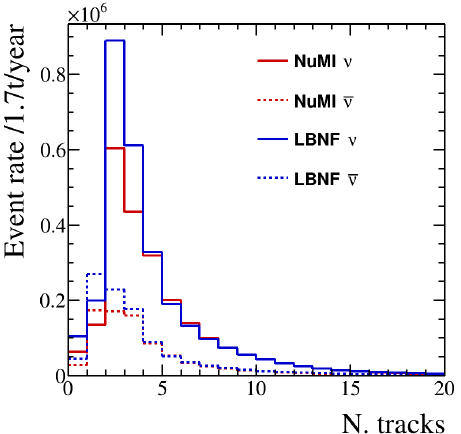
Figure 21. The yearly rates of minimum and highly ionizing particles expected in the demonstrator’s